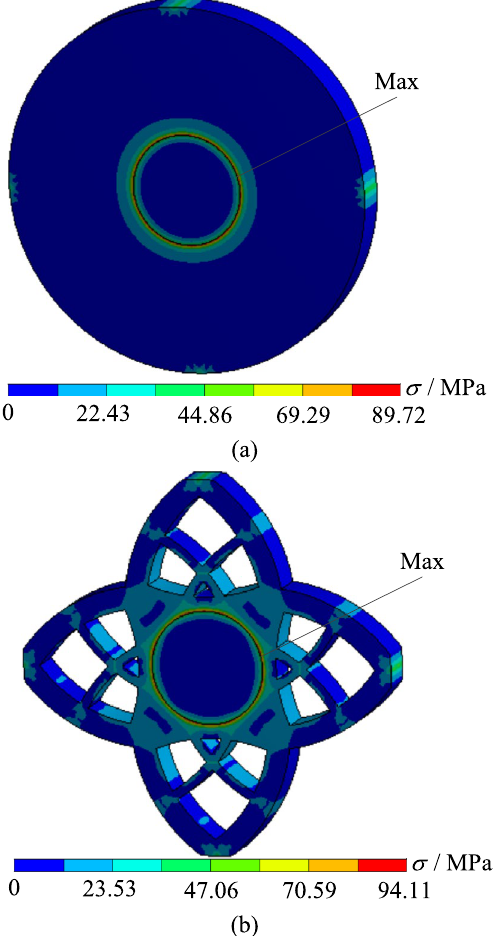
Figure 20. Comparison of stress contour figures before and after optimization. ( a ) Stress contour figure of the original model ( b ) Stress contour figure of the reconstructed